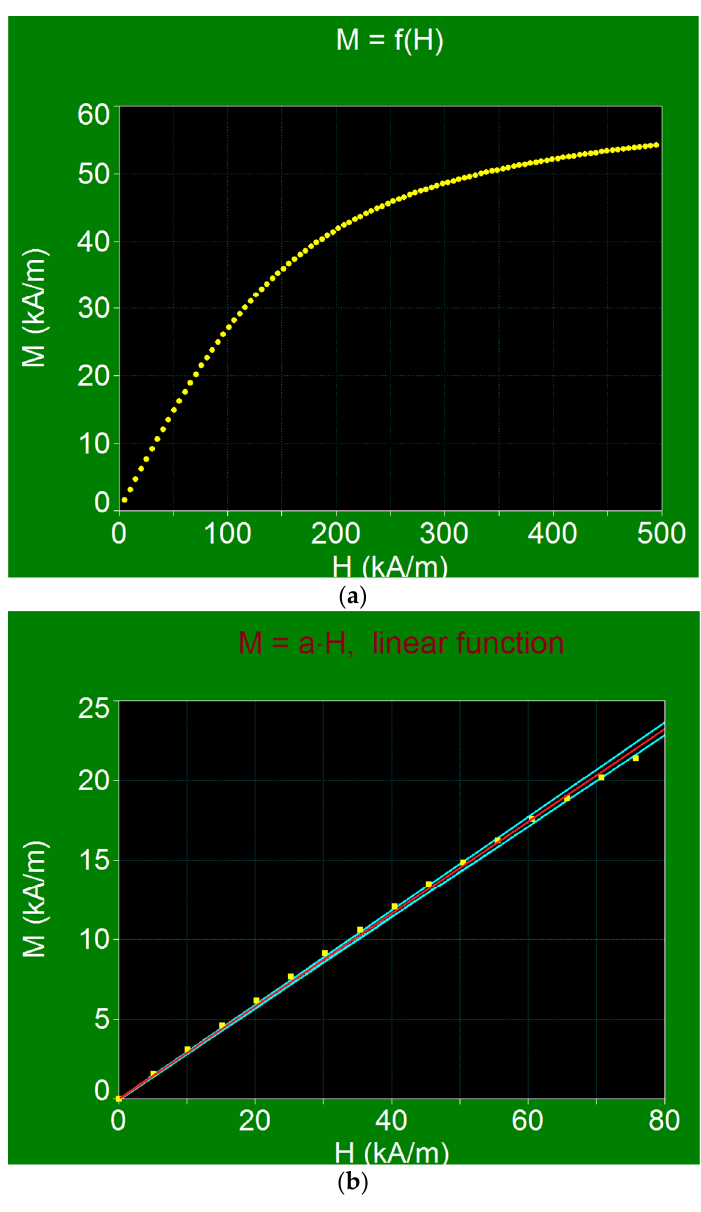
Figure 7. The magnetization M as a function of magnetic field H for CoFe 2 O 4 nanoparticles in ( a ) high and ( b ) low magnetic field.